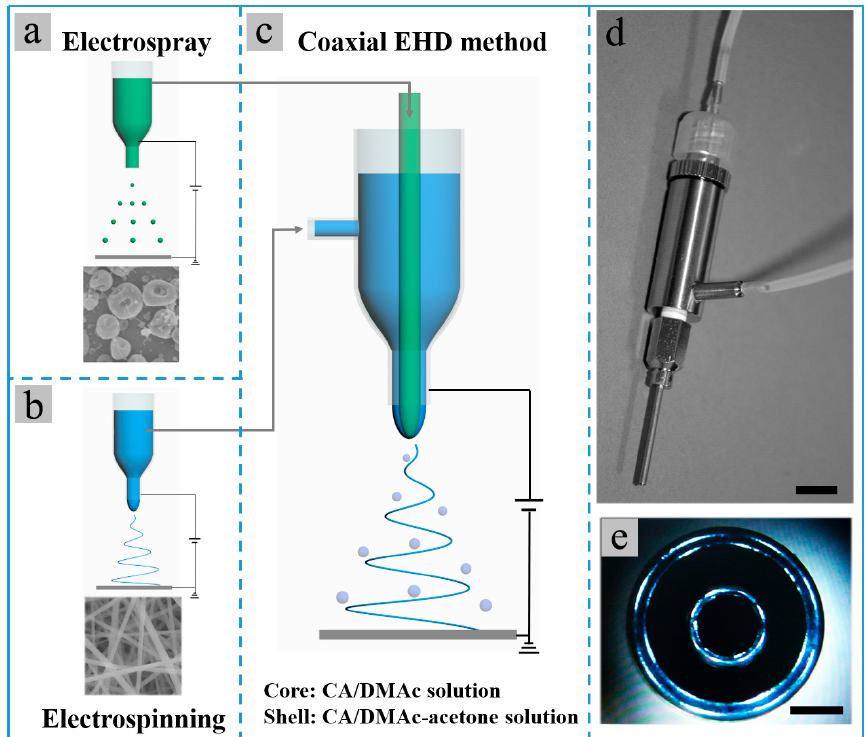
Figure 1. ( a – c ) Schematic for the ( a ) single-nozzle electrospray of CA-D solution, ( b ) single-nozzle electrospinning of CA-AD21 solution and ( c ) co-electrospinning of core CA-D solution and shell CA-AD21 solution; ( d , e ) photographs of the coaxial bi-channel spinneret used in the co-electrospinning experiments. The scale bars in ( d ) and ( e ) represent 1 cm and 0.5 mm, respectively.